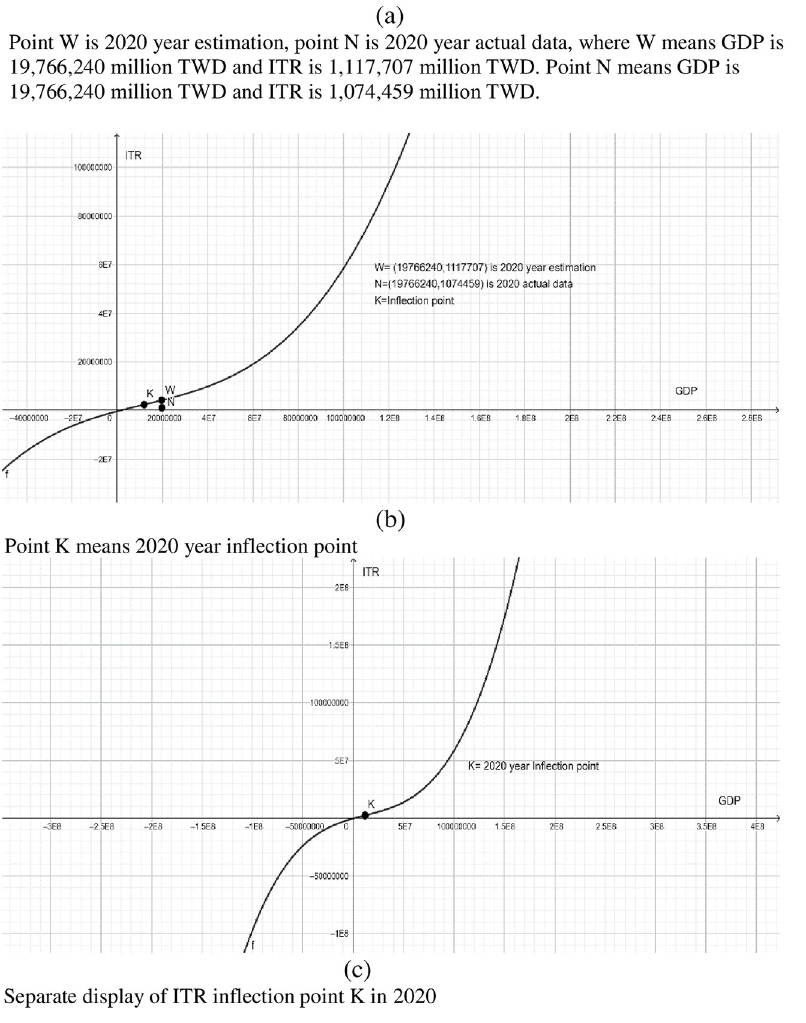
Fig 4. ITR-to-GDP, Taiwan,